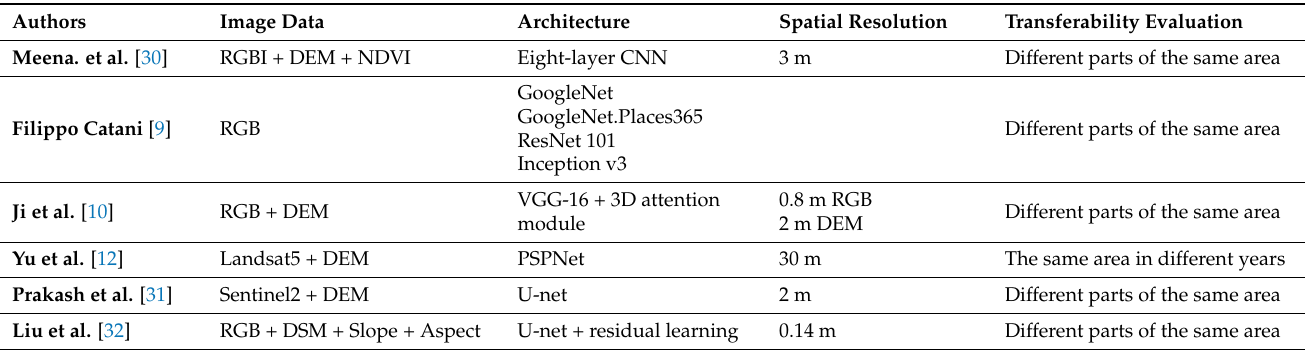
Table 1. Recent studies on landslide detection using deep learning models: “RGB” indicates spectral channels of red, green, and blue, “I” is the infrared channel, “DEM” is short for digital elevation model, and “NDVI” is the normalized difference vegetation